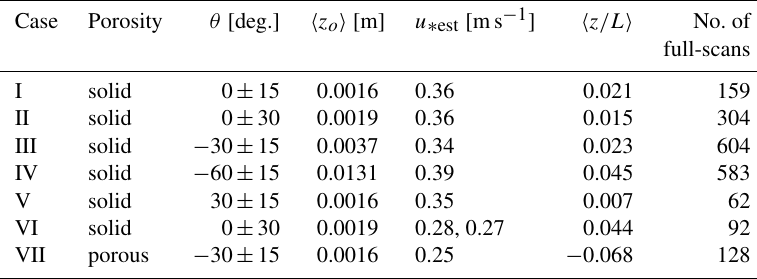
Table 4. Case studies for a number of θ intervals. Refer to the text for